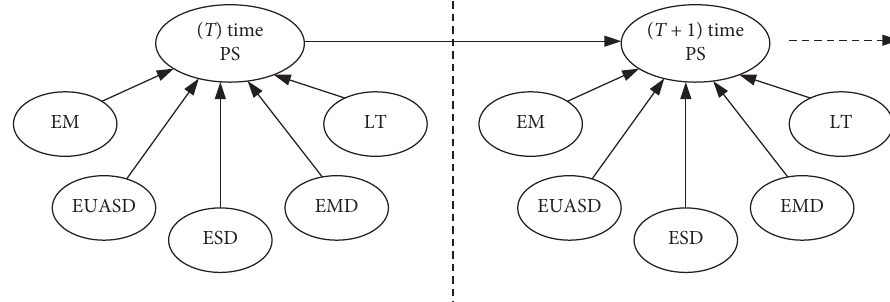
Figure 4: The threat assessment dynamic model for the UUV’s security status.